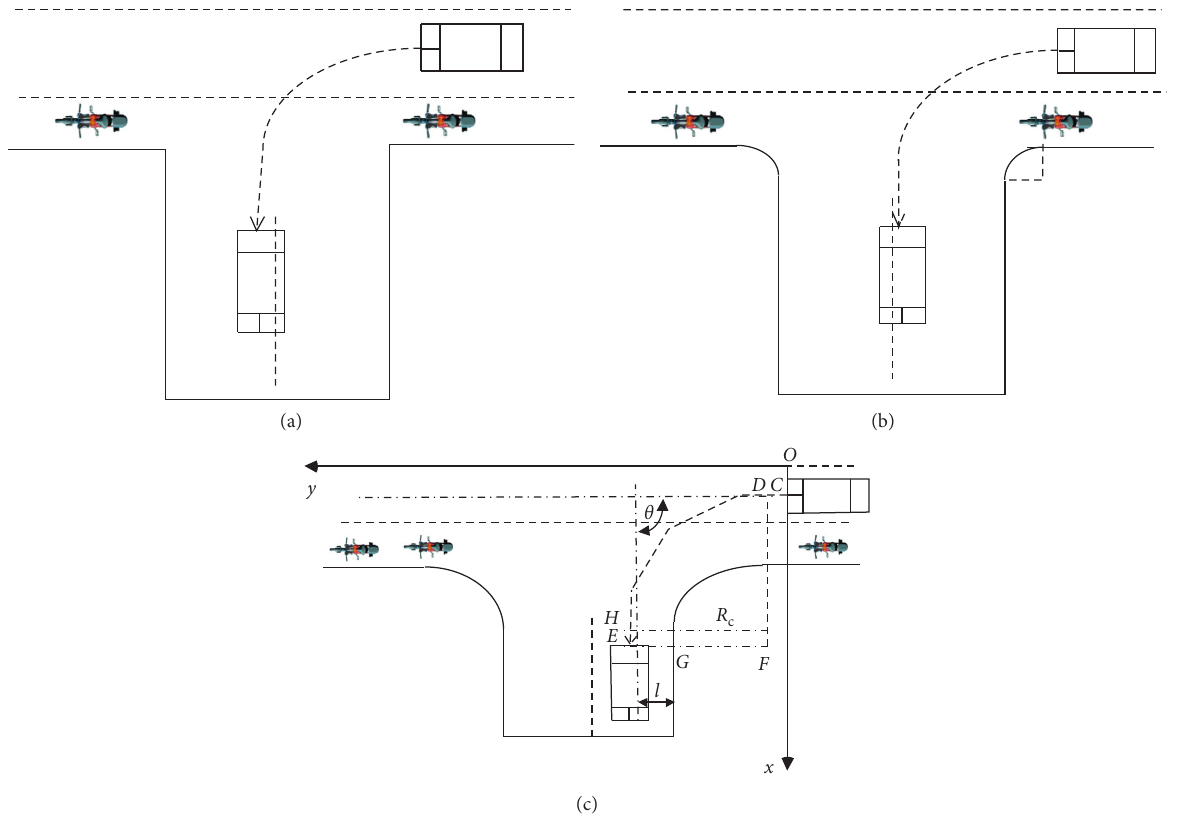
Figure 12: Left turns on the driveway. (a) Driveway without entering radius. (b) Driveway with small entering radius. (c) Driveway with large entering